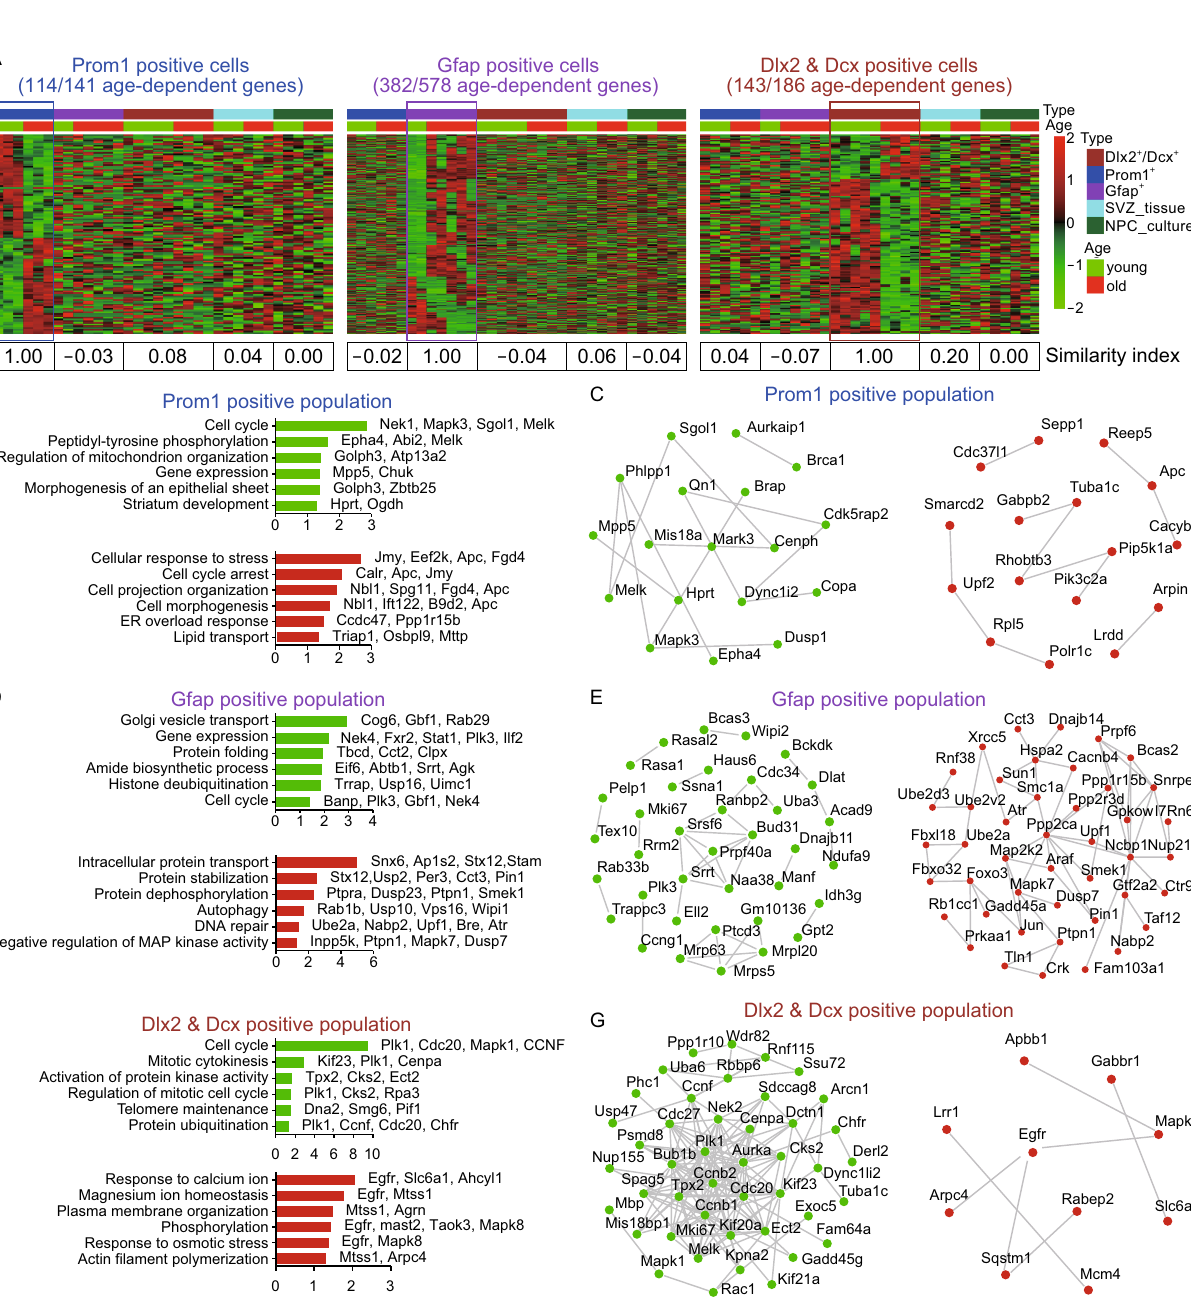
Figure 6. Differential gene expression analysis revealed age-dependent molecular alterations in distinct SEZ/SVZ cell subpopulations. (A) Heatmap of age-dependent differential genes from three distinct SEZ/SZV subpopulations, including Prom1 + cells, Gfap + cells, and Dlx2 + /Dcx + cells respectively. Cross-data comparisons of expressions of each of these three cell type-speci fi c age-dependent gene panels (excluding those not detected in any one of the 5 types of samples) in the rest of the 5 samples including SEZ/SVZ tissue samples and cultured NSC/NPCs. Similarity index was calculated for each of the three gene panels across 5 types of samples. (B and C) GO analyses and STRING protein-protein interaction network of age-dependent 141 genes (up- and down- related genes) in Prom1 + subpopulation. (D and E) GO analyses and STRING protein-protein interaction network of age-dependent 578 genes (up- and down-related genes) in Gfap + subpopulation. (F and G) GO analyses and STRING protein-protein interaction network of age-dependent 186 genes (up- and down-related genes) in NBs subpopulation. Length of bars indicated the signi fi cance ( − log10 transferred P -value, Fisher exact